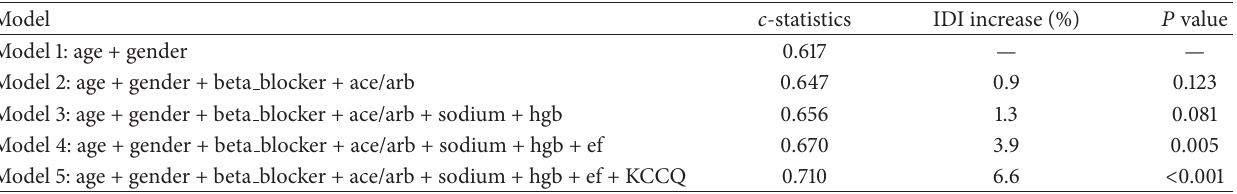
Table 4: Prognostic value of readmission within 30 days after discharge of different models comparing to model 1 with only demographic